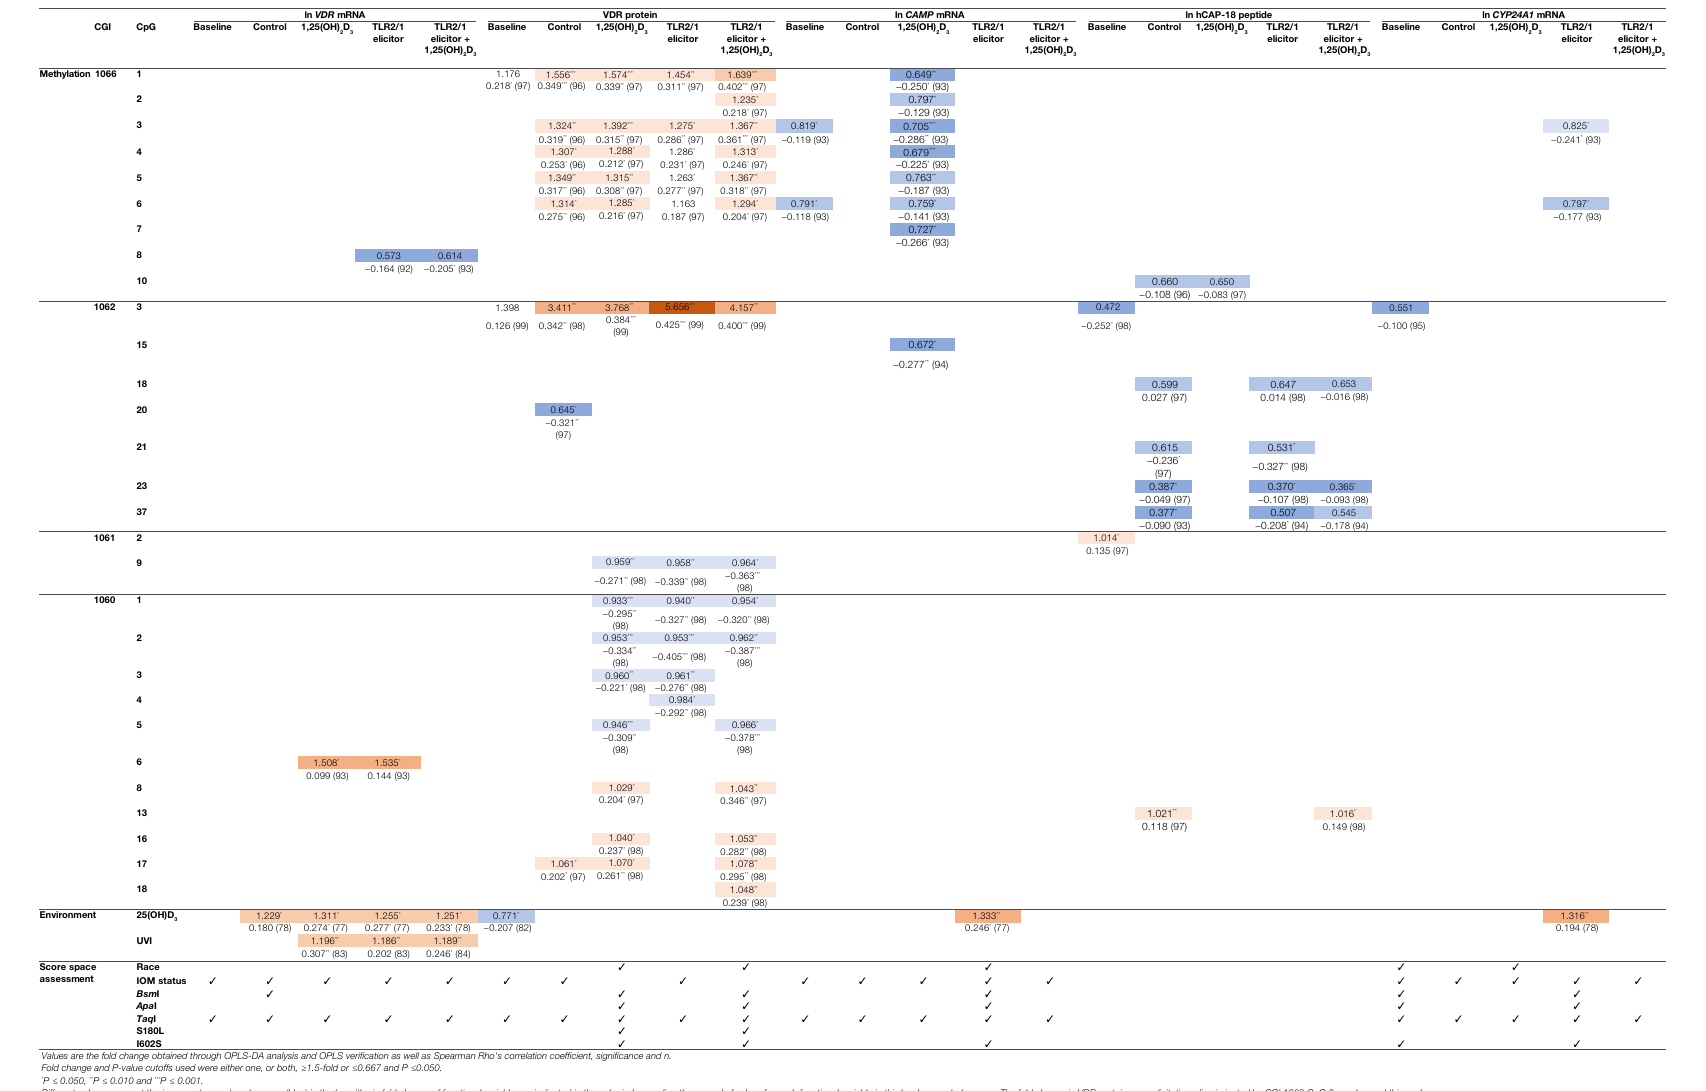
TaBle 4 | Fold change (above/below average means) and correlation for functional variables, significantly and/or prominently, impacted by VDR methylation, 25(OH)D 3 , and UVI, together with population clustering, observed through score space assessment. CGI CpG Baseline Control 1,25(OH) 2 D 3 TLR2/1 elicitor